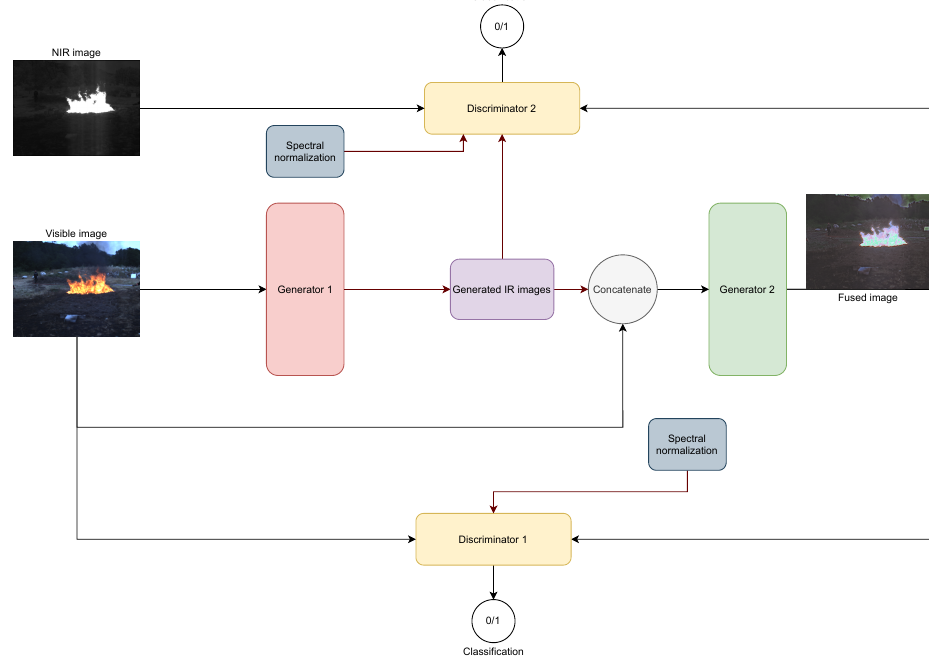
Figure 5. Structure of the Fire-GAN model proposed by Ciprián-Sánchez et al.